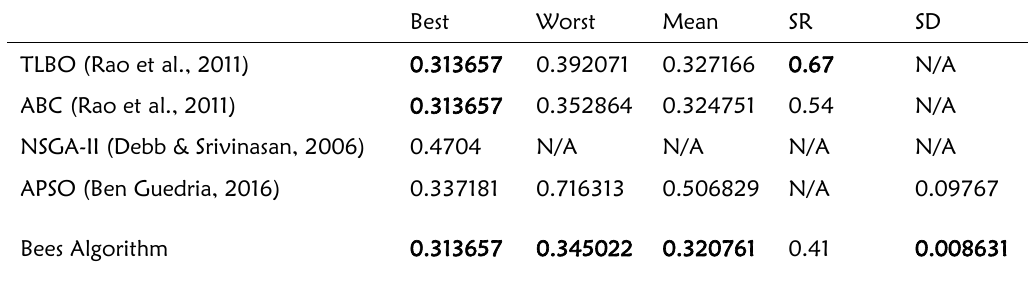
Table 2: Result Comparison with other Optimisation Algorithms